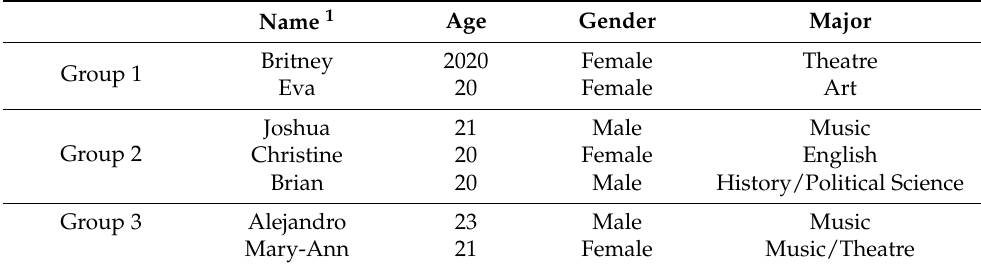
Table 1. Participants’ background